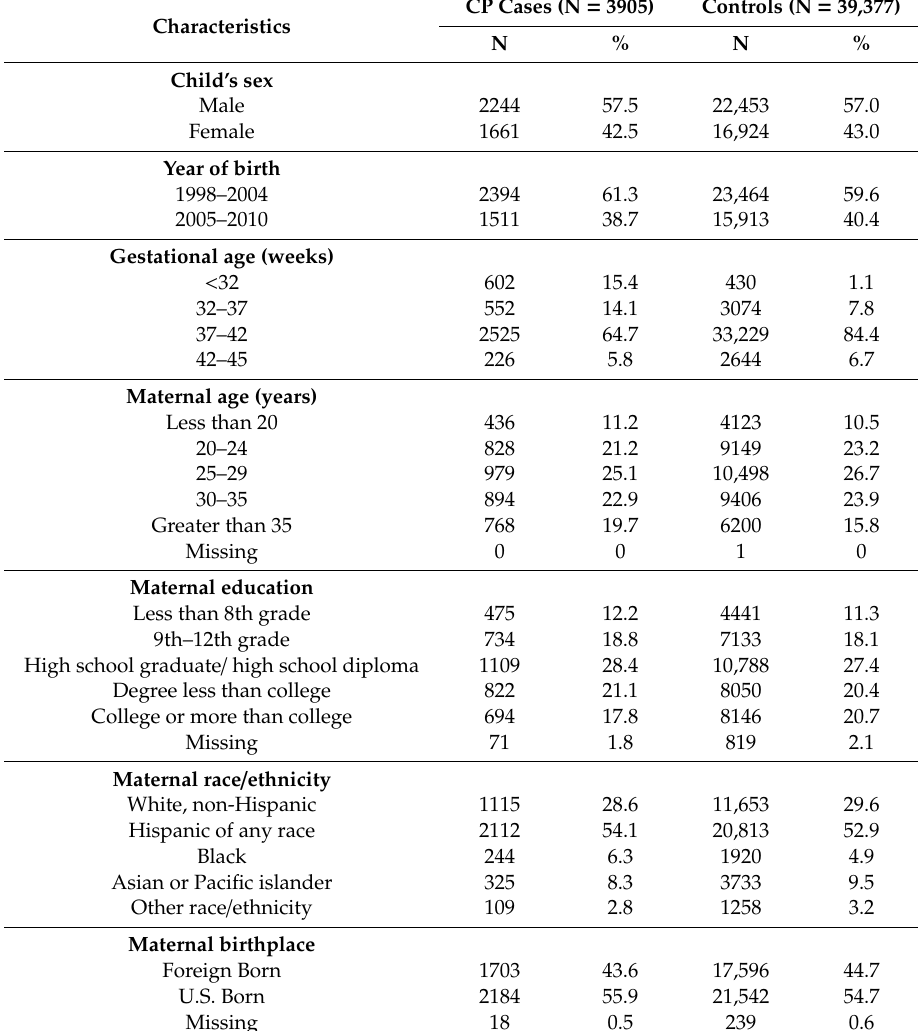
Table 1. Characteristics of the cases and controls selected from the study area in California, 1998–2010. CP: cerebral